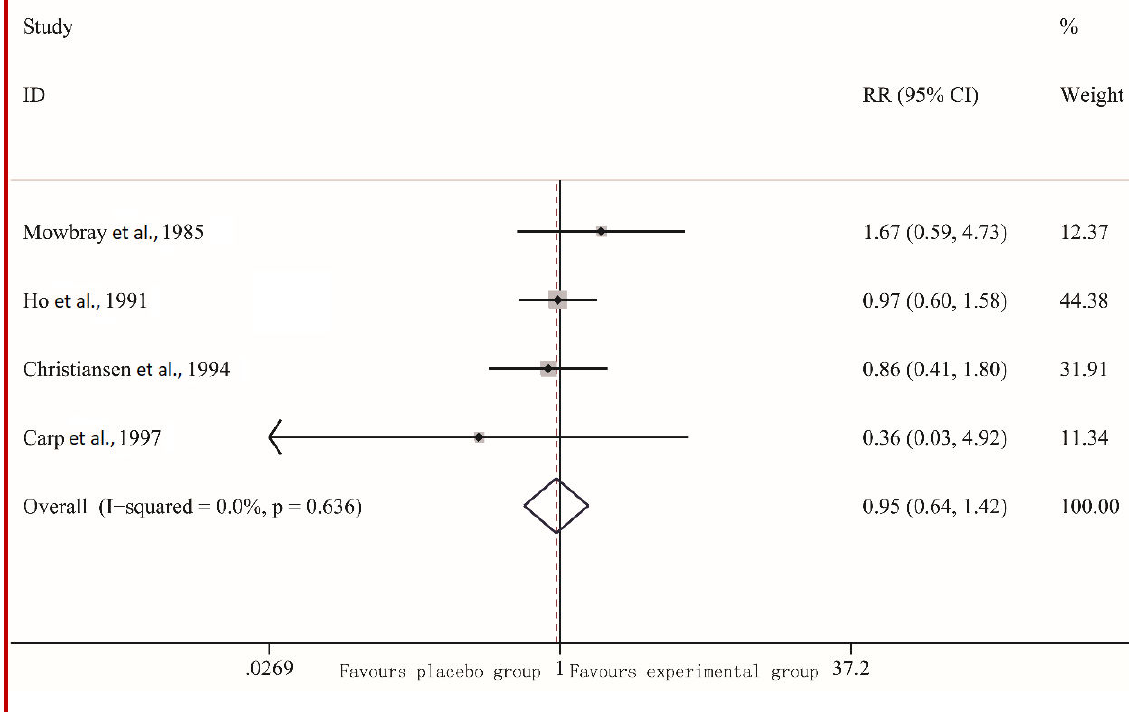
Figure 7: Forest plot comparing secondary RSA in immunotherapy and placebo groups